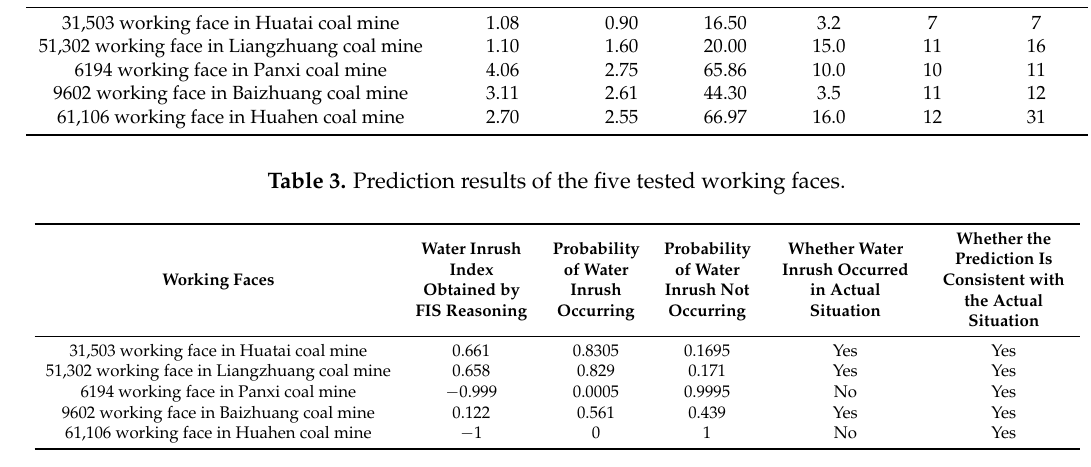
Table 2. Geological data of the five working faces used for prediction.